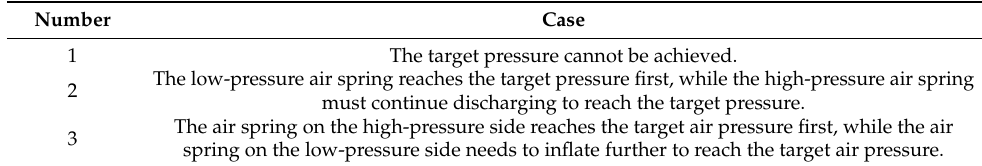
Table 2. Three categories of pressure in the air suspension.